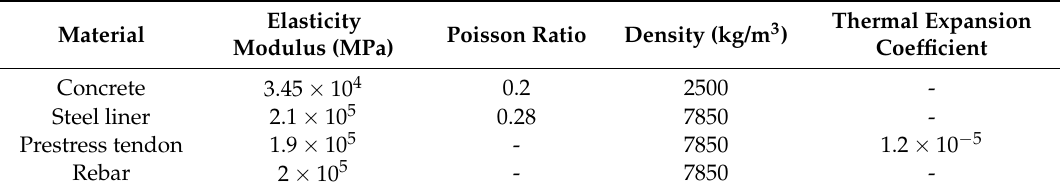
Table 1. Material properties of the finite element method (FEM)